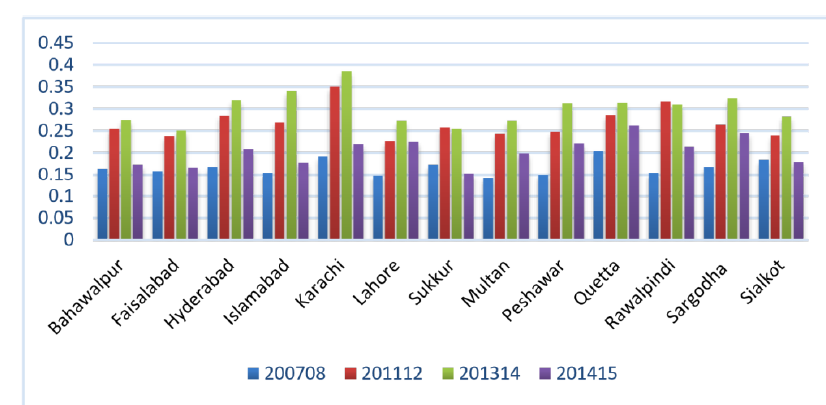
Fig. 1: Volatility in Food